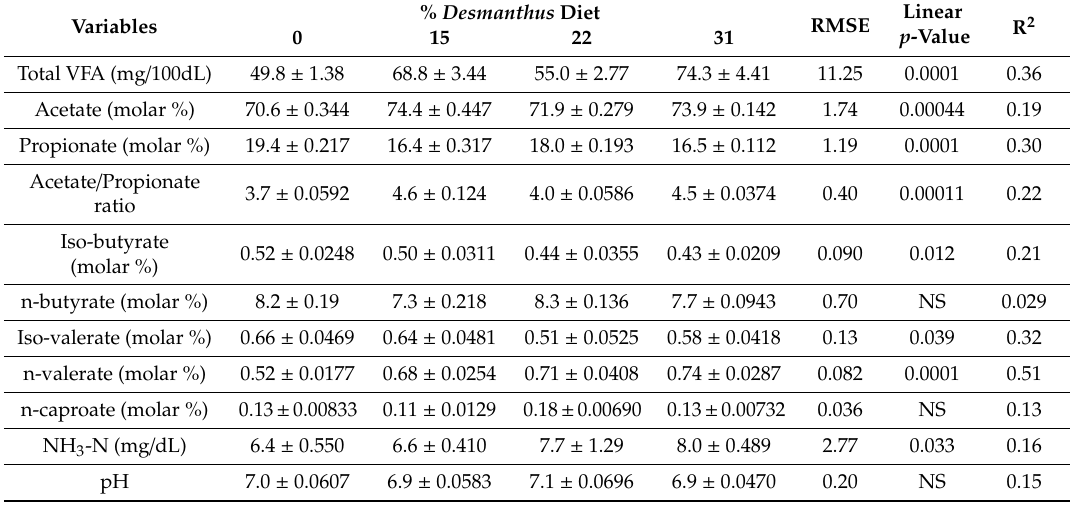
Table 4. Relationship between the products of rumen fermentation and the percentage of Desmanthus (on dry matter basis) in the